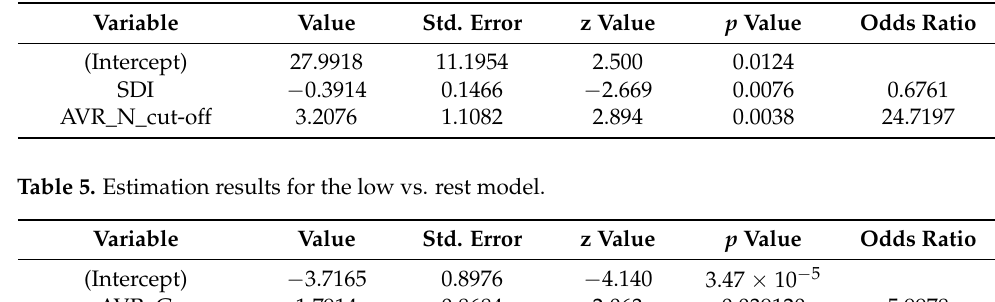
Table 4. Estimation results for the high vs. rest model.